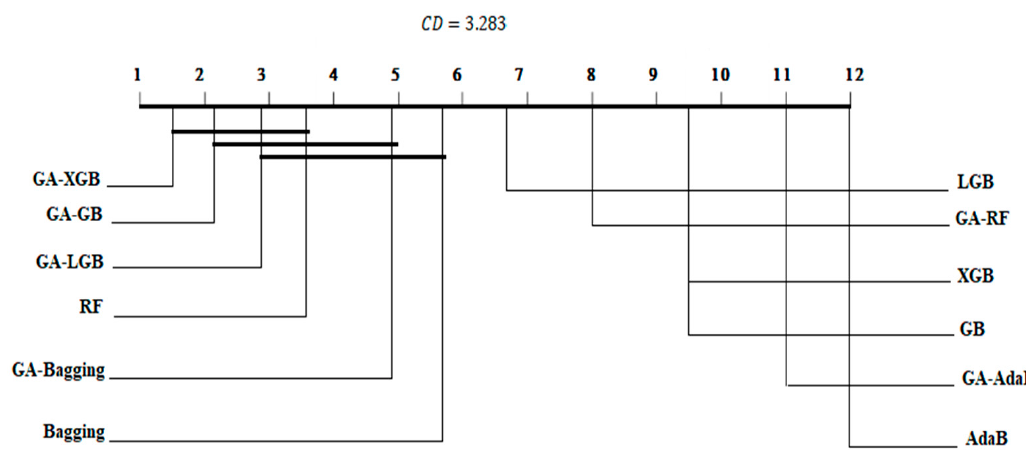
Figure 11. Critical difference diagram of Dataset 3 for the Nemenyi test.